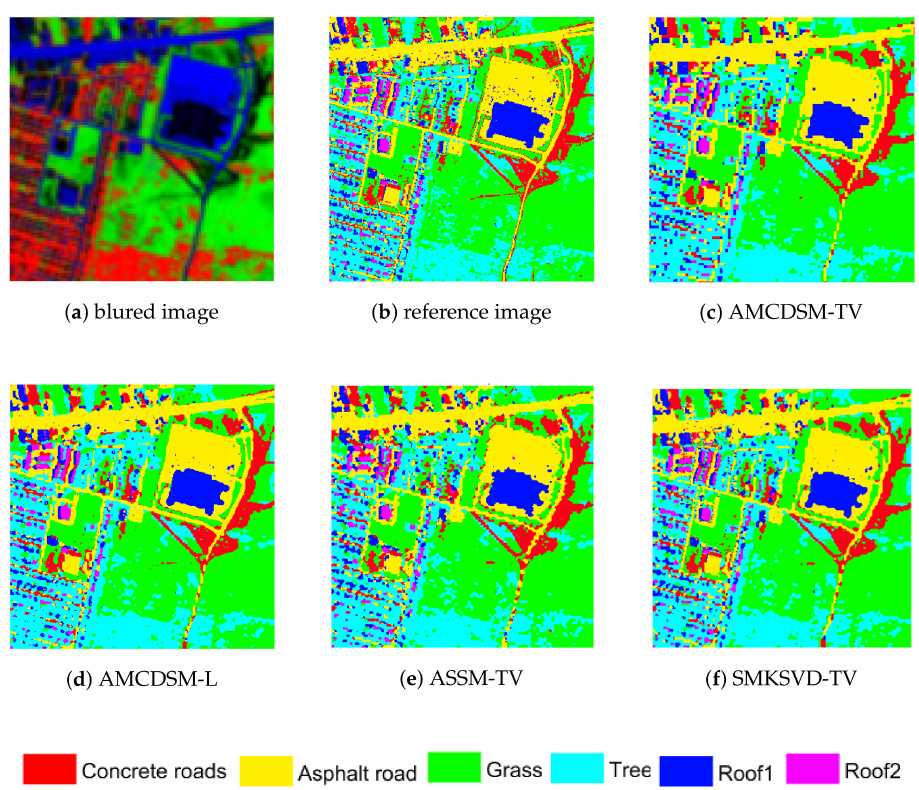
Figure 10. Sub-pixel mapping results of HYDICE urban image.